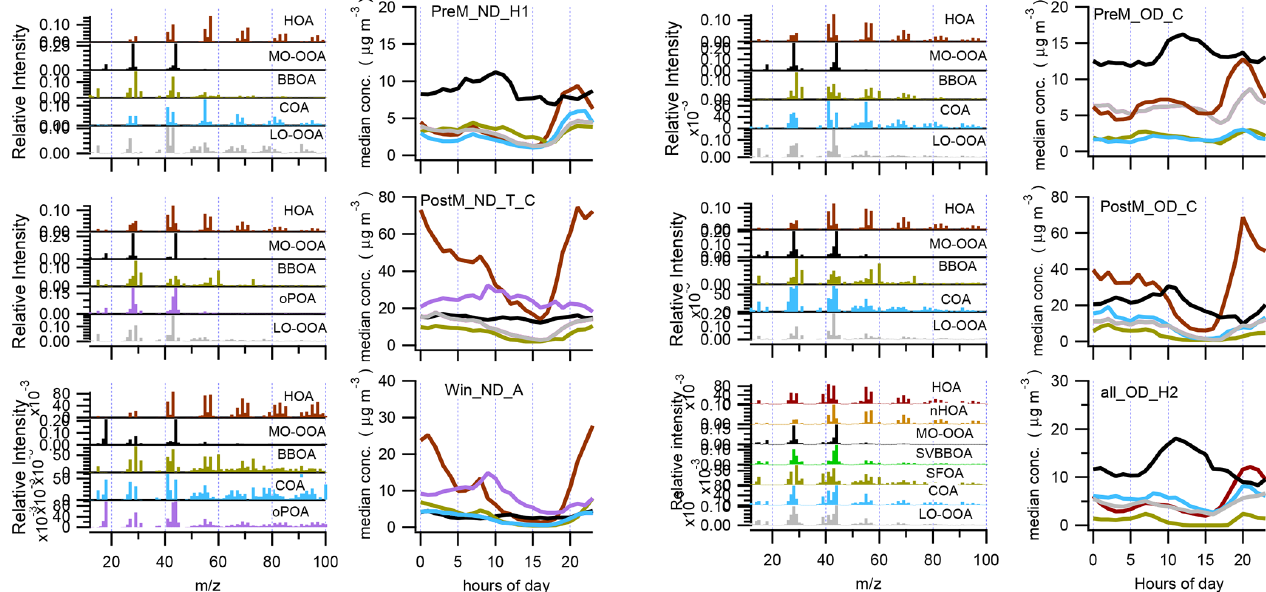
Figure 4. Mass spectra and diurnal plots of OA factors from PMF analysis in the different periods. Here the period all_OD_H2 is dis- played to compare with the other periods. The period all_OD_H2, which shows the high-resolution PMF analysis performed with the complete dataset of the AMS instruments (H2) 26 May–23 November 2018, is analysed in detail by Cash et al. (2021). Detailed analysis of the all_OD_H2 dataset is presented in Table S4, where the PMF analysis identified seven factors, adding HOA = HOA + nHOA and BBOA = SFOA + SVBBOA to compare with our five-factor solutions.